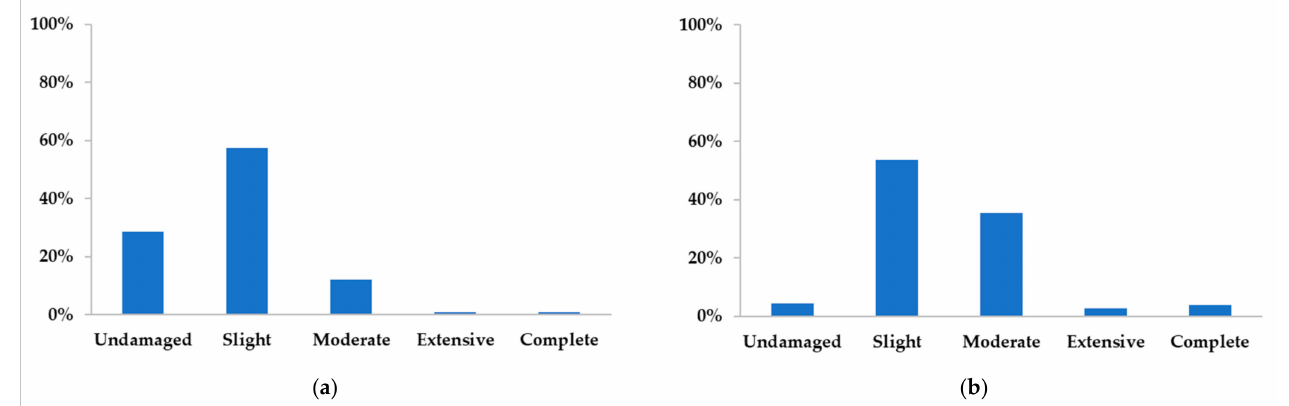
Figure 14. Discrete damage probabilities of the model building due to design earthquake of DBE ( a ) and MCE ( b